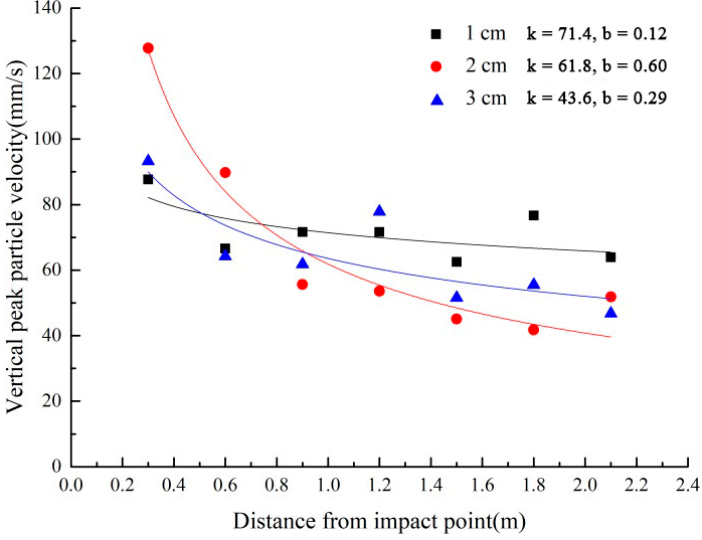
Figure 15. The dynamic response of double-layer plate with different cementing joint thicknesses.